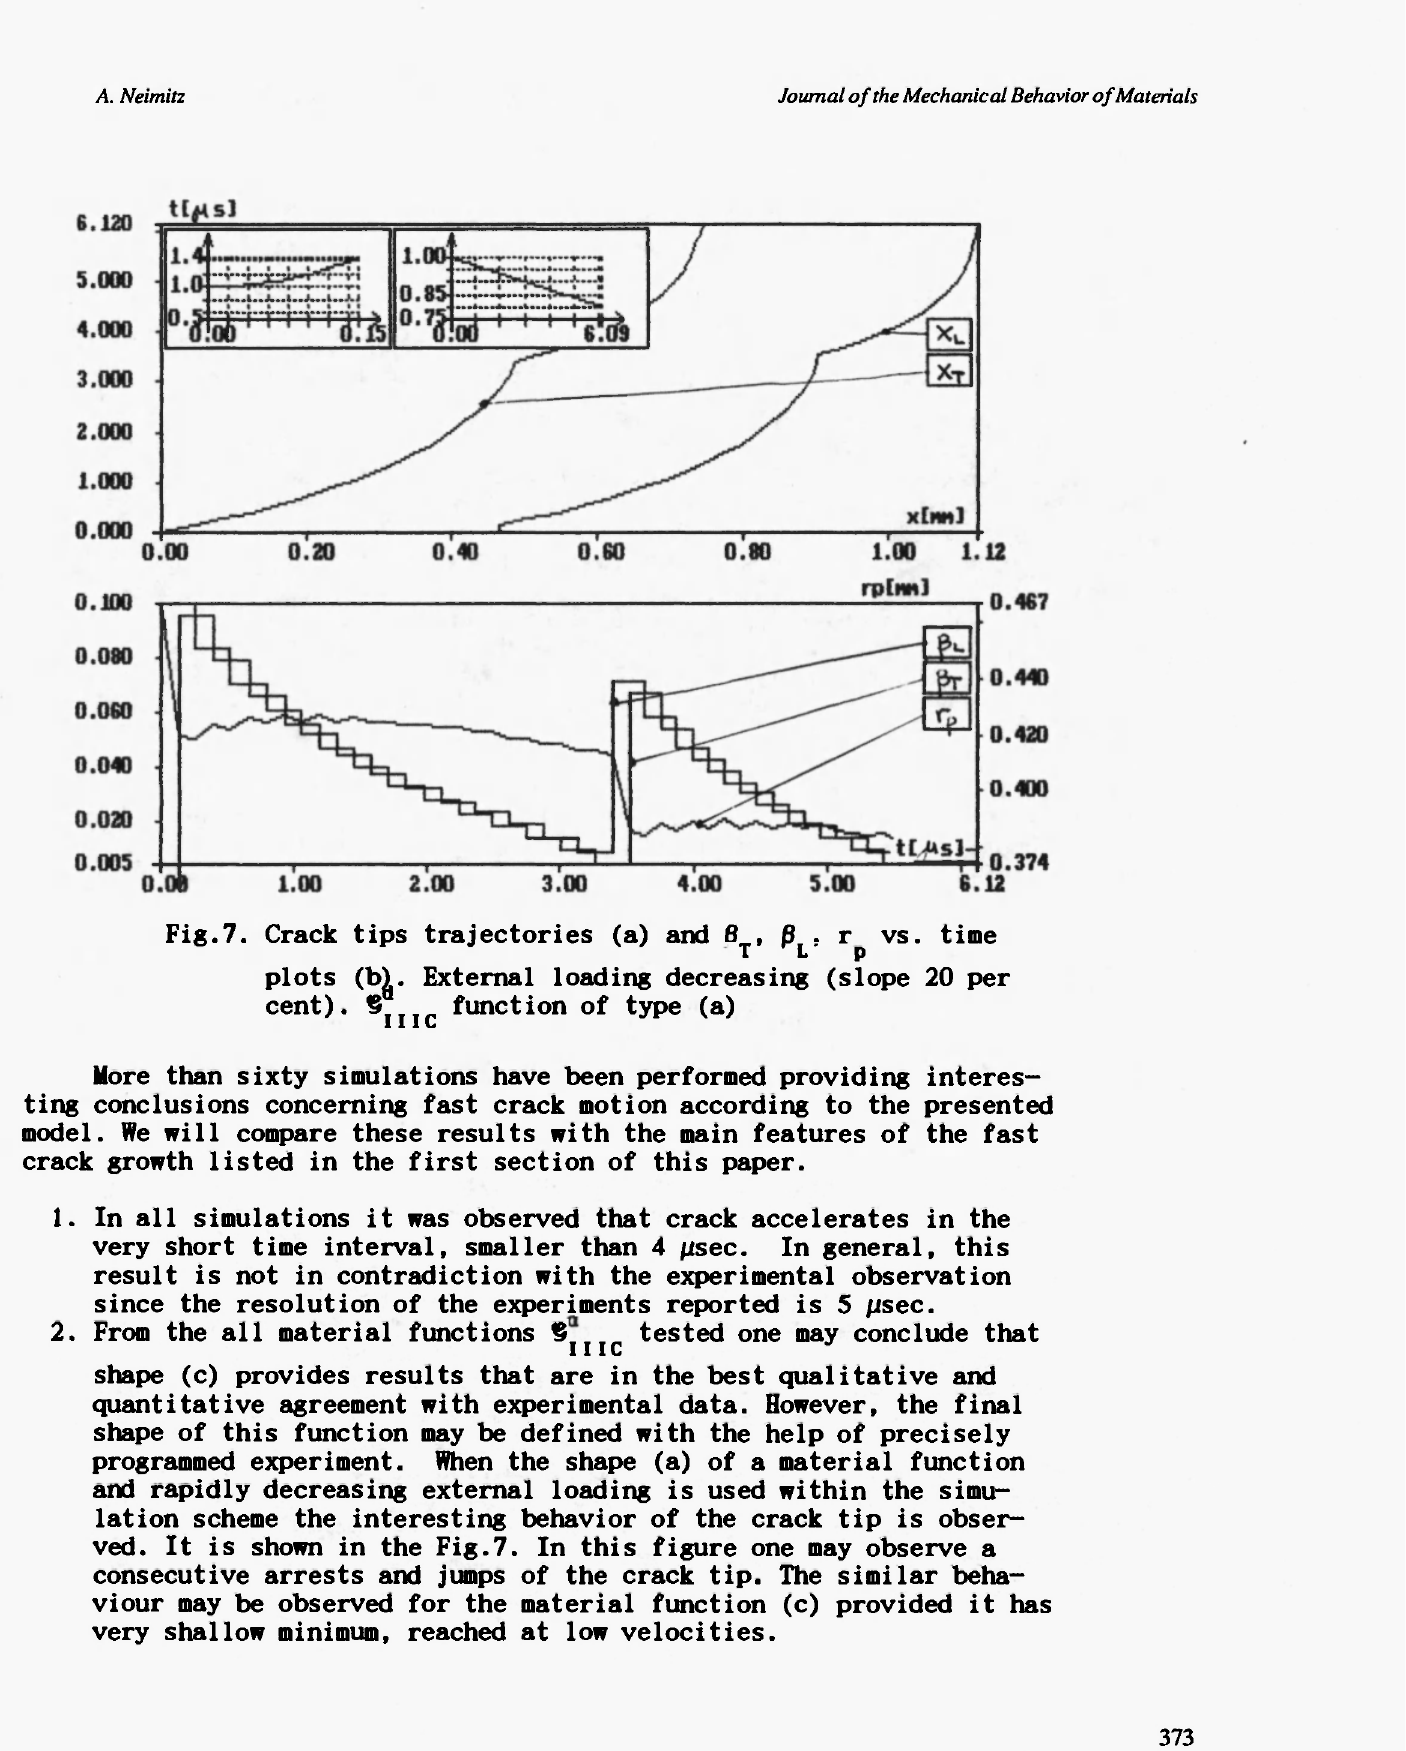
Fig.7. Crack tips trajectories (a) and ß , β. r vs. time Τ L ρ plots (b^. External loading decreasing (slope 20 per cent). S function of type I I IC